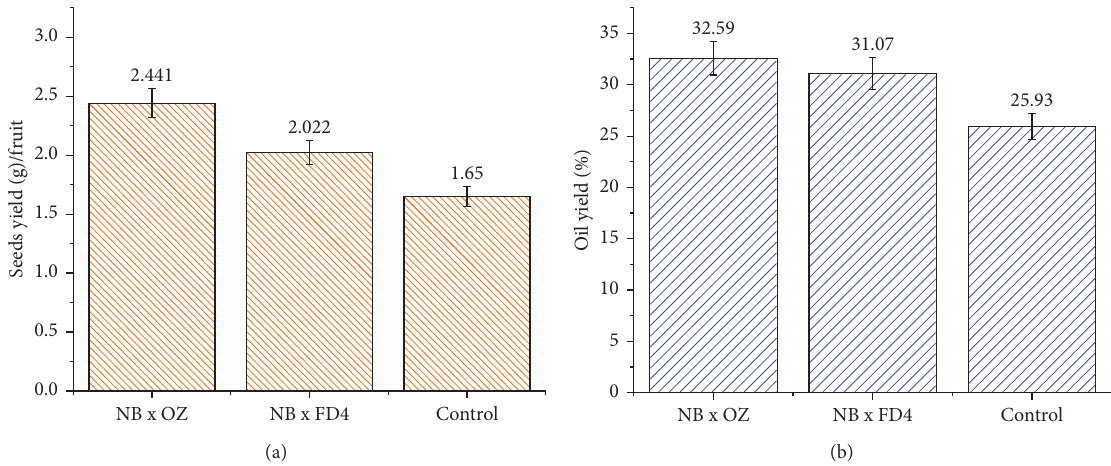
Figure 1: Effect of pollination and pollen source on seeds (a) and oil (b) yields. NB refers to the variety “Nabout,” while OZ and FD4 are the two caprifigs used as a source of pollen and denote “Ouzidane” and “Frond d’Oued N ° 4,”